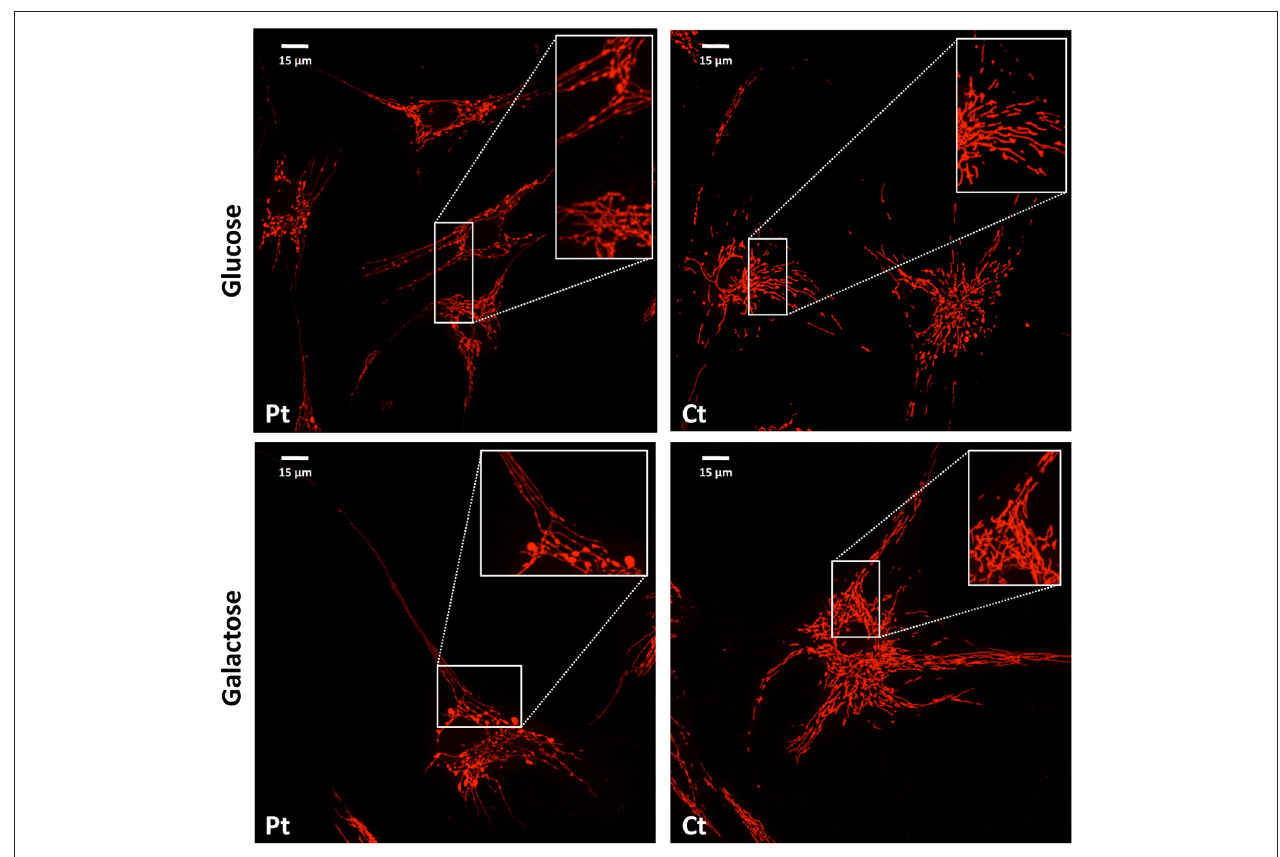
FIGURE 3 | Mitochondrial network analysis in patient fibroblasts. Representative images of the mitochondrial network in fibroblasts from the patient (Pt) and a control subject (Ct), cultured in either glucose (Upper) or galactose (Lower) medium. In the inset, a digital magnification (3x) shows the peculiar ‘chain-like’ structure observed in Pt cells. Scale bar: 15 µ